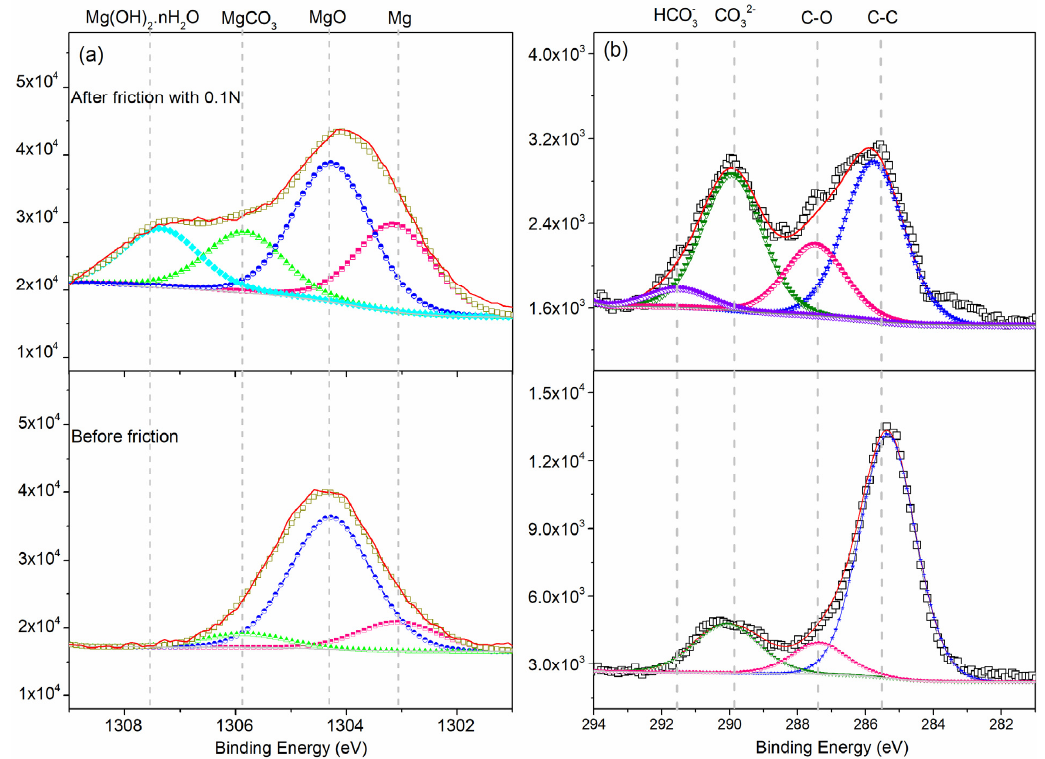
Figure 11. Comparison the binding energies of the ( a ) Mg 1s and ( b ) C 1s peaks before and after sliding friction.